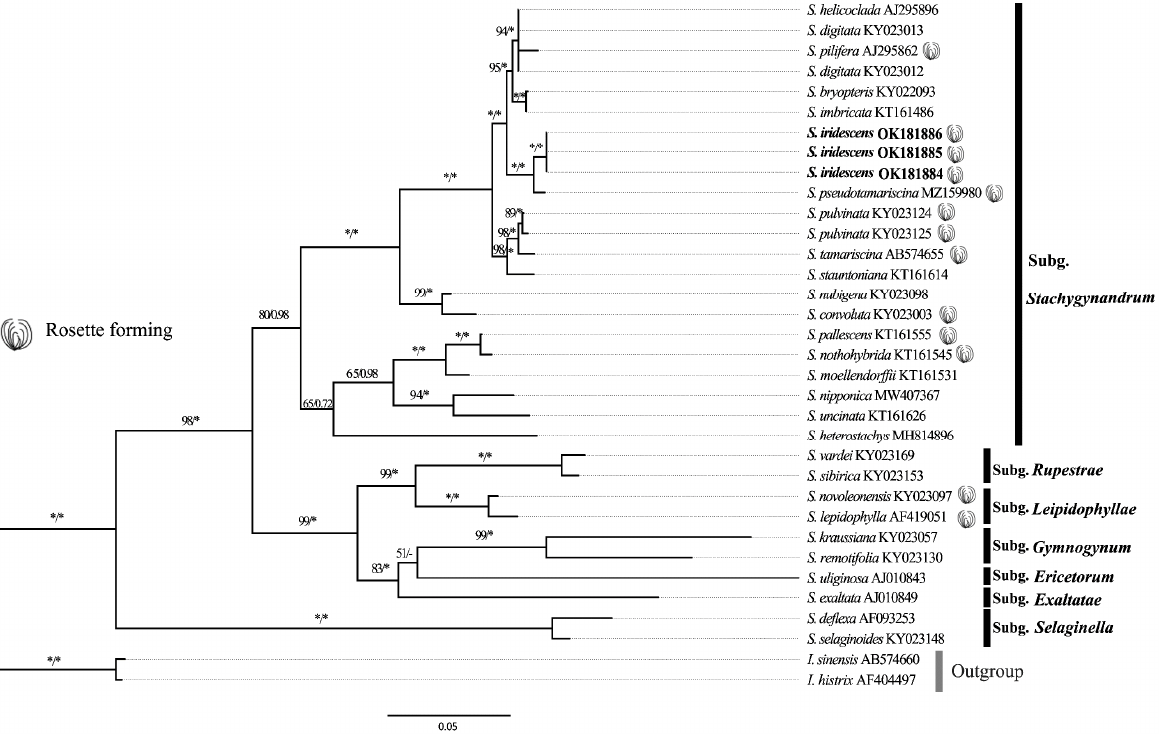
Figure 5. Maximum likelihood tree based on the rbcL gene. Maximum likelihood bootstrap (BS) and Bayesian inference posterior probability (PP) are noted above the branch (PP/BS, * = 1 or 100%).